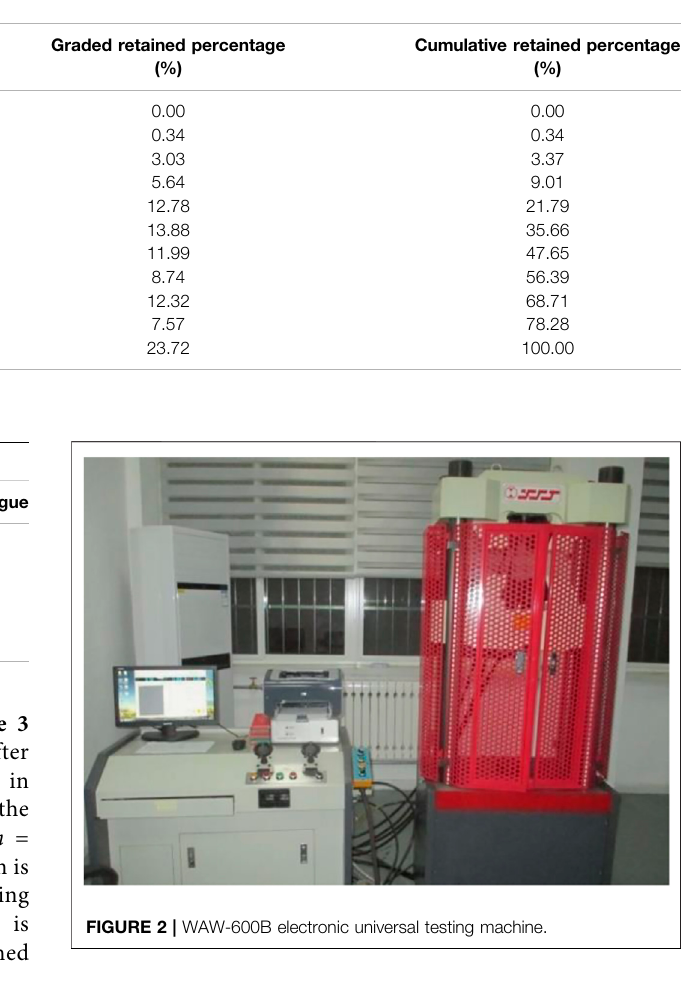
Percent passing (%) Graded retained percentage